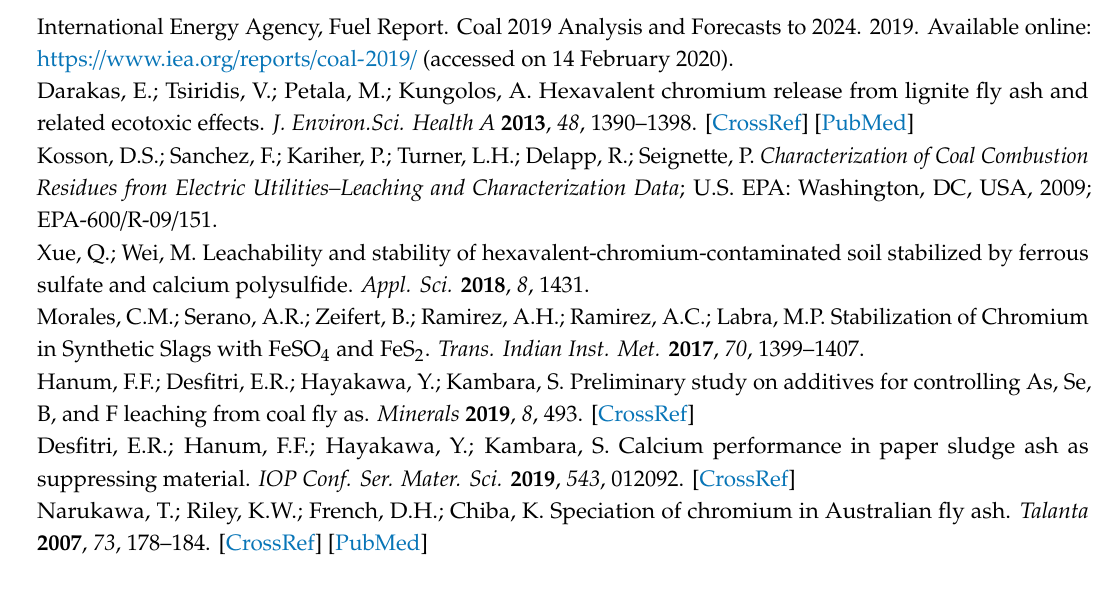
Figure 7. Leaching rate comparison between laboratory experiment and FactSage simulation.